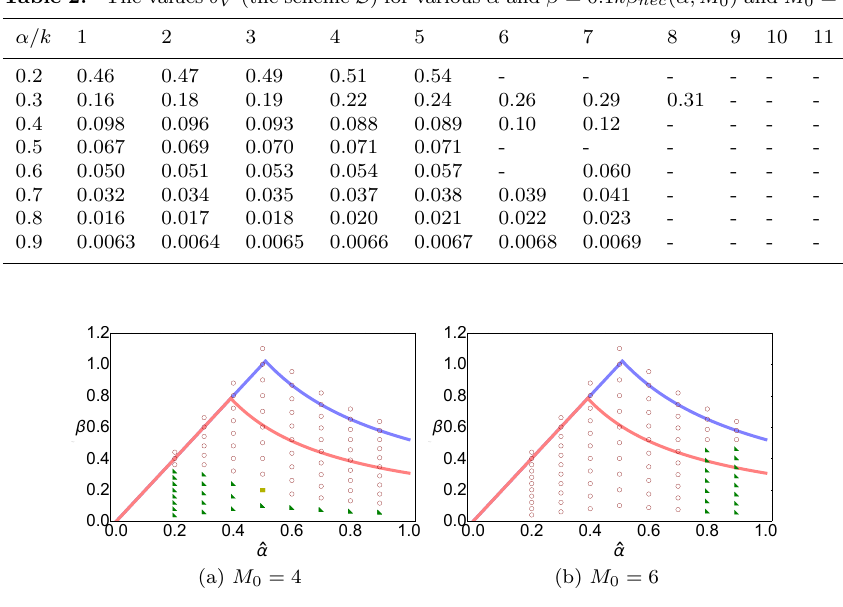
In Figure 9 for M 0 = 2 and α ≥ 0 . 3 as well as M 0 = 4 , 6 and α ≥ 0 . 2, the results correspond well to condition (4.2) for M = M 0 . But for α = 0 . 1 (that is the closest value to the maximum point of the right-hand side of (4.2) for M = 0 and M = M 0 = 4 , 6) all the computations are unstable. All numerical results for α and β violating condition (4.2) for M = M 0 are also